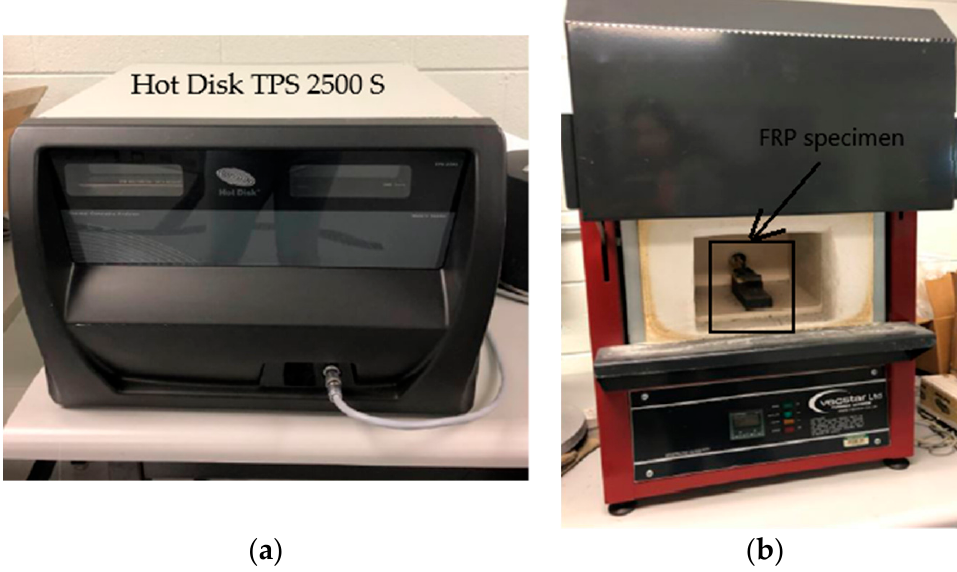
Figure 1. Equipment setup for hot disc method: ( a ) hot disc thermal constant analyzer and ( b ) furnace.